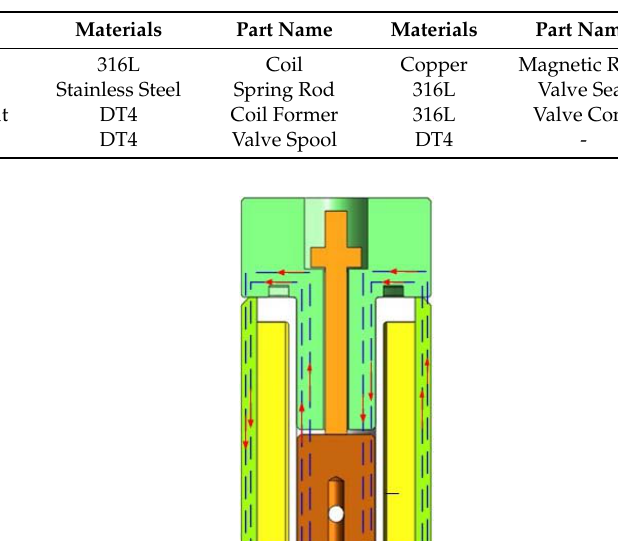
Figure 2. Magnetic circuit diagram of the digital valve.